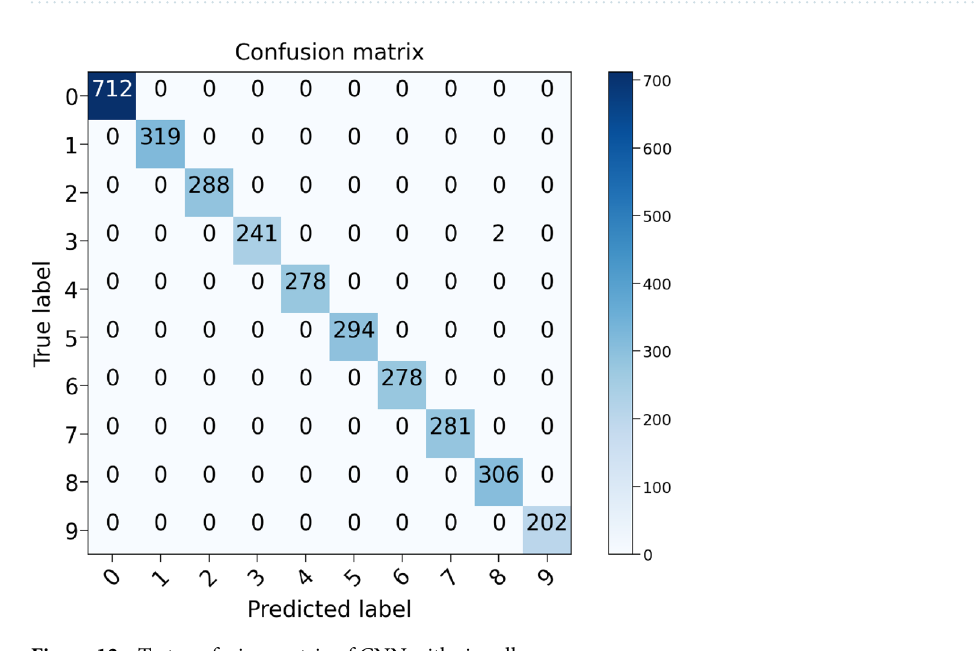
Figure 11. Loss and accuracy of CNN with six cells in the training process ( a ) and validation process ( b ).